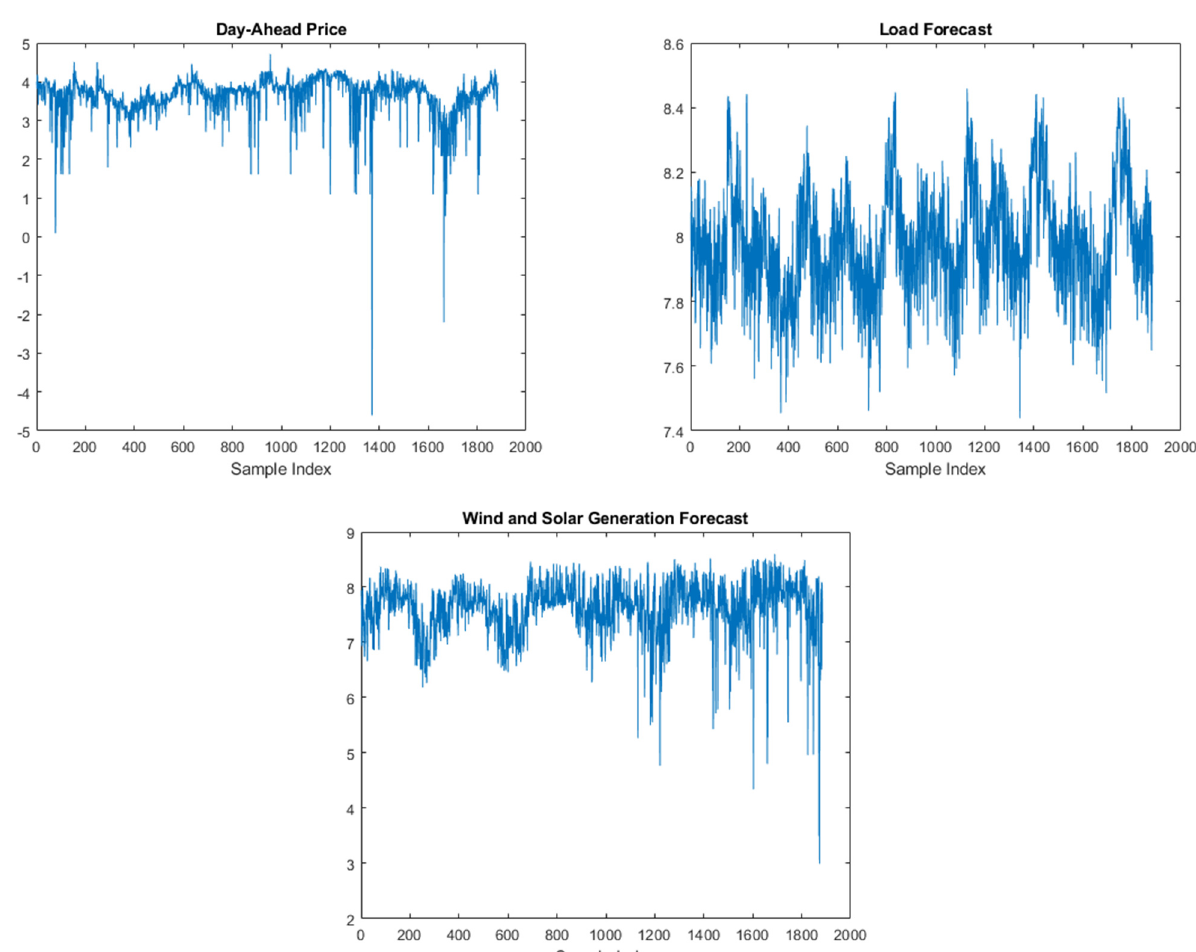
Figure 1. Time plots of the basic model variables for the Italian market (the reference hour is H15). The y-axis is logarithmic.